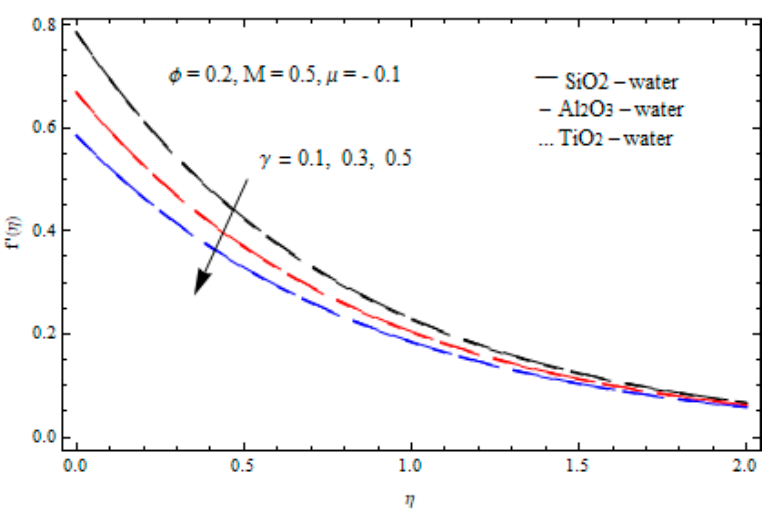
2 -water nanofluids.